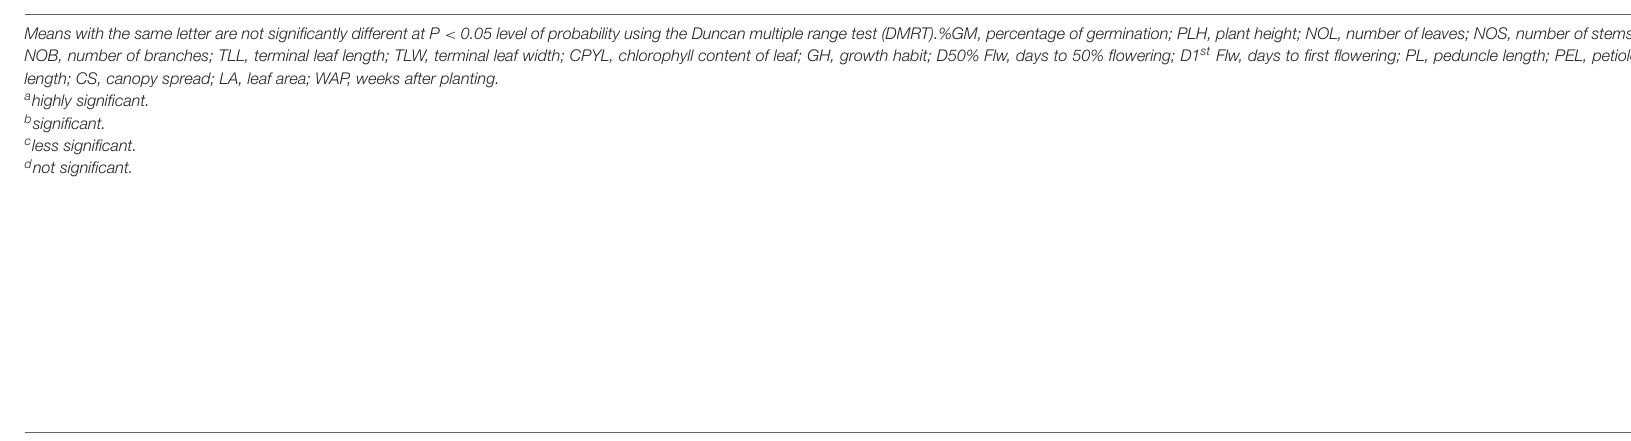
TABLE 7 | Effect of N fertilizer and B. japonicum strains on growth traits and biomass yield of accessions of Bambara groundnut at 12 WAP in Ibadan and Ikenne during both seasons. Treatment